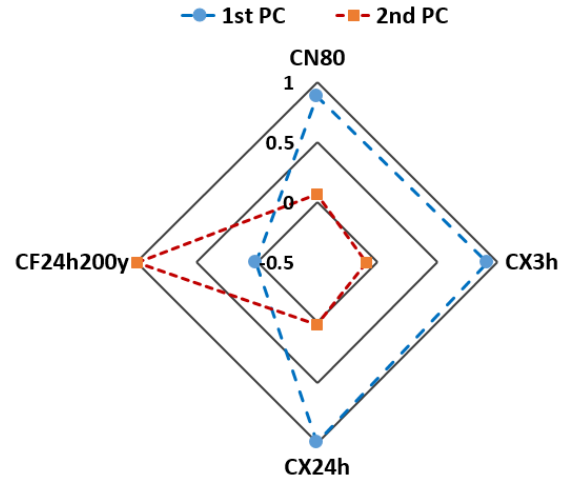
Figure 5. Factor loadings of climate exposure for the first and second principal component. PC stands for principal component.